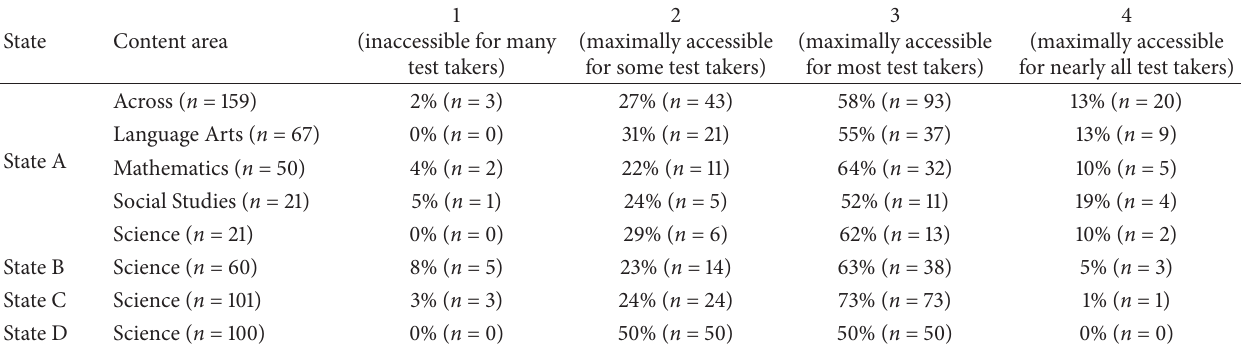
Table 6: Percentages of items at each overall accessibility level, by content area and